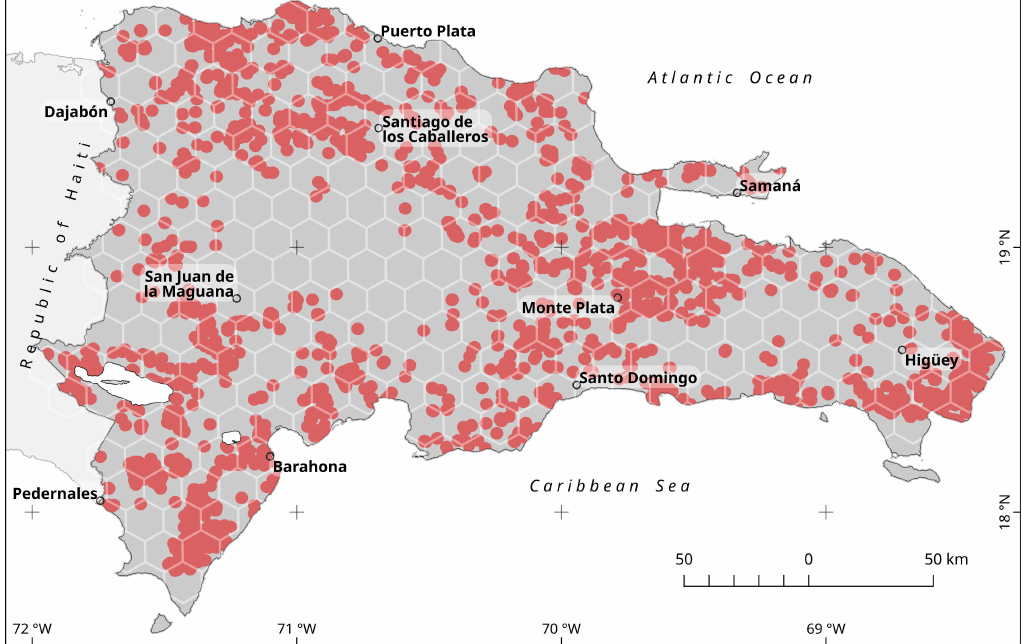
Figure S6 – Example of the 2013 forest loss areas and their vicinity (red shaded areas) used in the annual trend approach. These areas were generated by adding a buffer zone of 2.5 km around each patch larger than 1 ha in area from the loss year dataset (MC Hansen et al., 2013). The hexagonal grid, depicted as an overlay, was used for zonal statistics computations. See text for details.